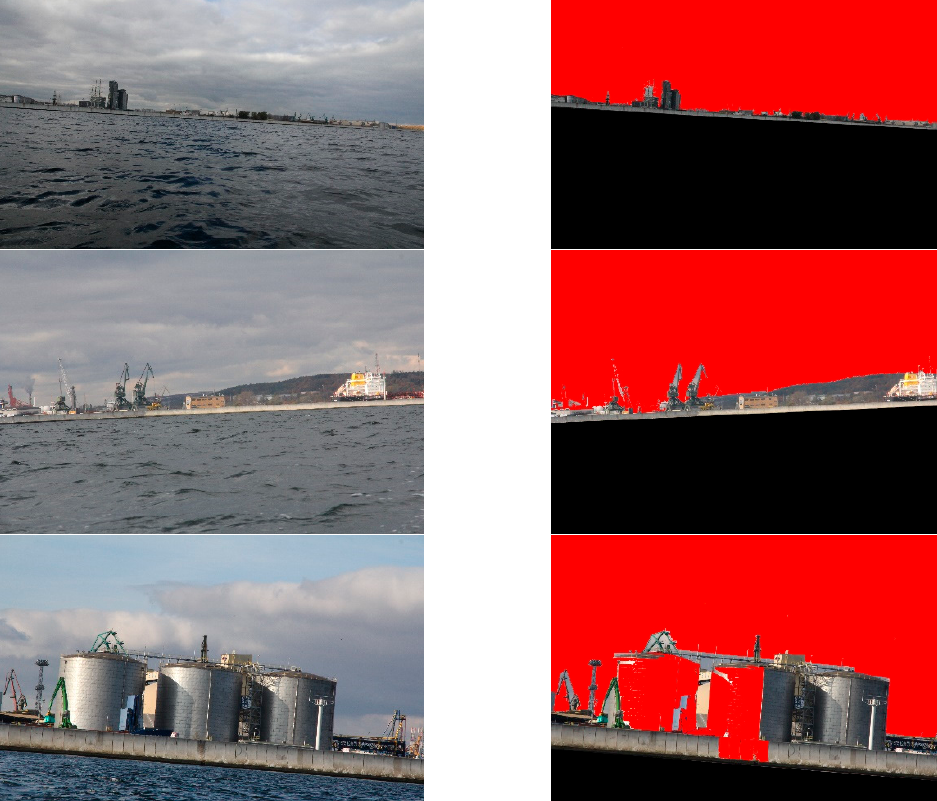
Figure 17. Results of the Watershed algorithm.